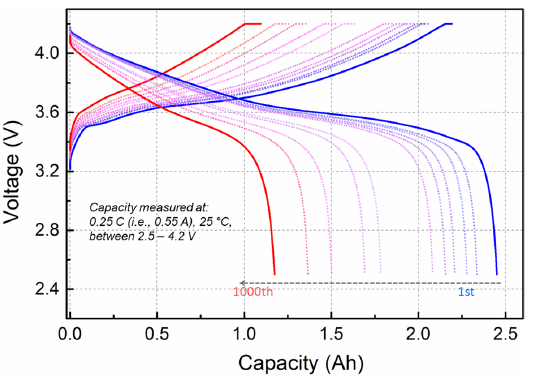
Figure 4. Evolution of the charging and discharging capacity voltage characteristic of a Li-ion battery during 1000 cycles; adapted from [28].